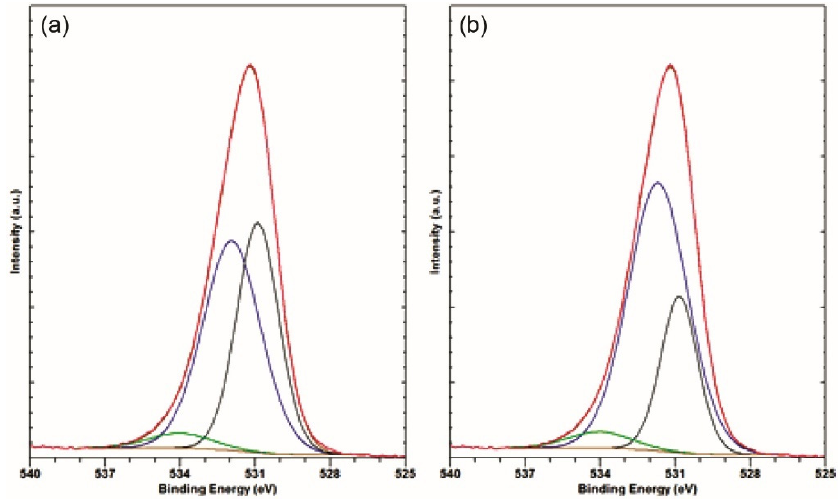
Figure 5. Two different fits of the same O 1s peak using the same components ( a , b ). Therefore, another strategy for estimating the Al oxide vs. Al hydroxide ratio was From this, c (Al O,OH )/ c (O Al ) = α ( p ) was calculated, which yielded the oxide share used. It is an improved and expanded second method from [42], where the ratio of the total Al and O concentrations was used to estimate the oxide/hydroxide ratio. The con- centration data from Table 2 were used to estimate the share of the oxygen bound in the phosphates and silicon oxide SiO x with x ≈ 1, which is indicated by Si 2p BE ≈ 101 eV. This share was subtracted from the total oxygen concentration to obtain the concentration of